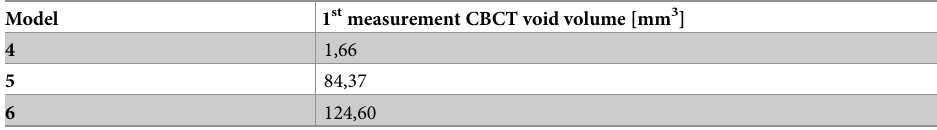
Table 1. Void volume measurements large-defect group.